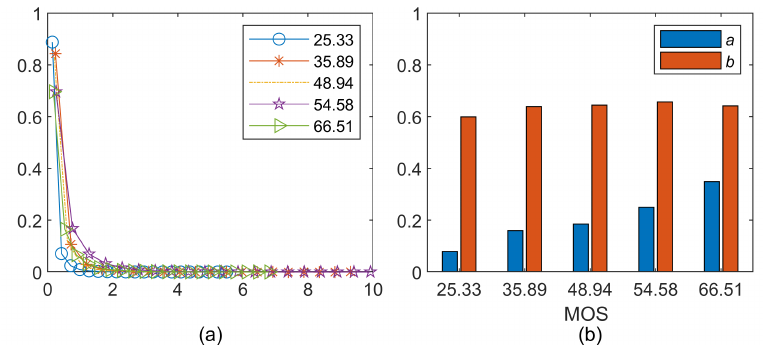
Figure 5. Distributions of the DFMs follow the Weibull distribution, and the distribution statistics of the DFMs increase as the MOS value grows: ( a ) distributions; and ( b ) bar plots of a and b